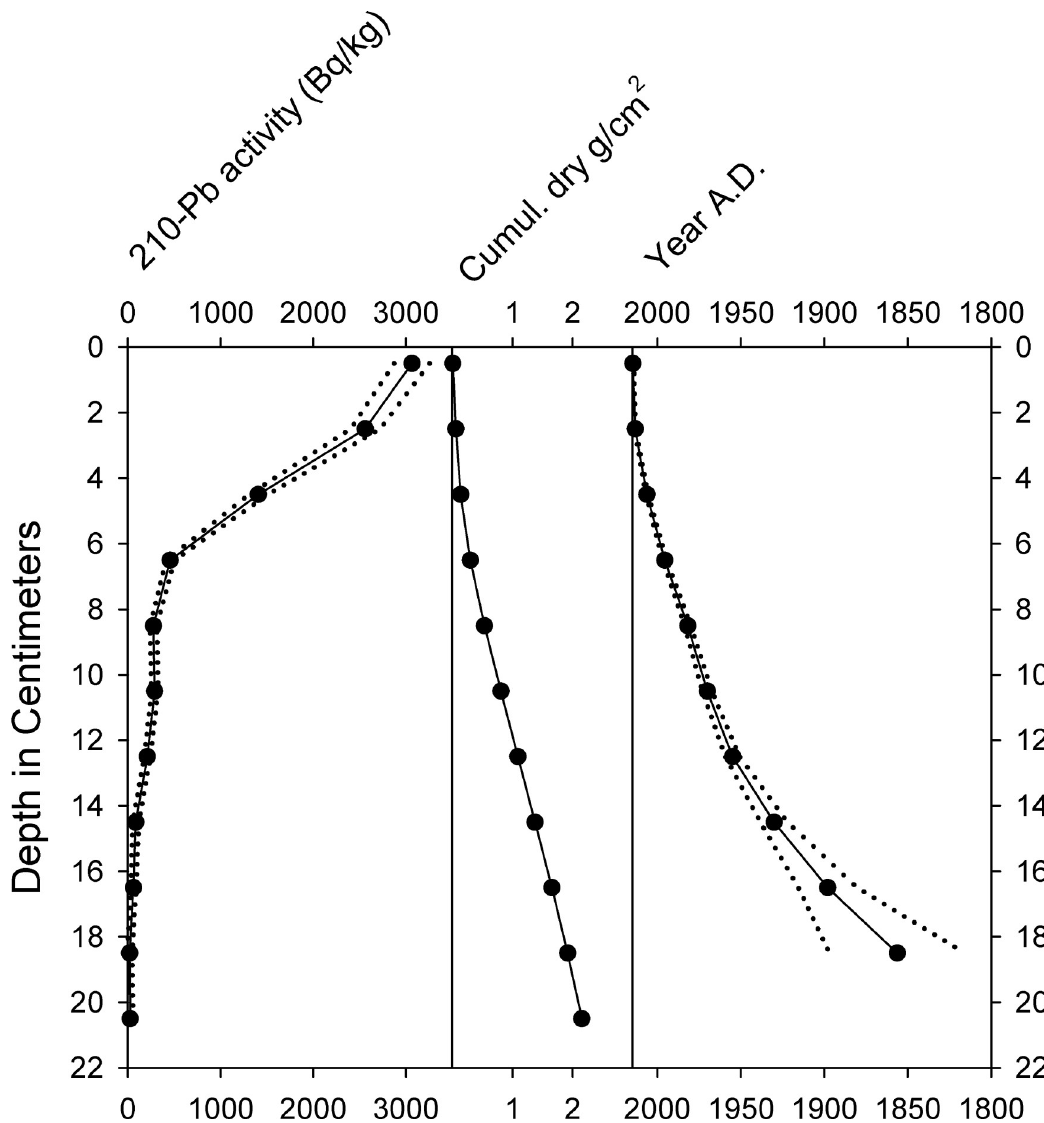
Fig 3. Activity of 210 Pb, sediment accumulation rates, and age-depth relationships in Little Green Pond core LG-2. Dotted lines indicate maximum/minimum ranges of the 210 Pb activities and radiometric